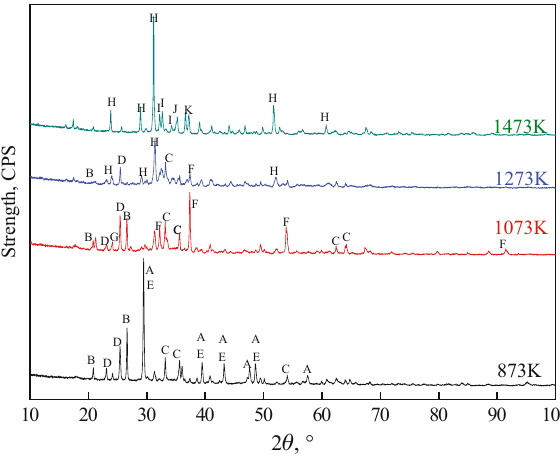
Figure 2: XRD patterns of coal ash after ashing at di ff erent tem - peratures. A – CaCO 3 ; B – SiO 2 ; C – Fe 2 O 3 ; D – CaSO 4 ; E – ( Mg )( CO ) ; F – CaO; G – 3CaO · 3Al 0.064 Ca 0.936 3 2CaO · Al 2 O 3 · SiO 2 ; I – Ca 2 SiO 4 ; J – Ca 2 Fe 1.52 Al 0.48 O 5 ; K –